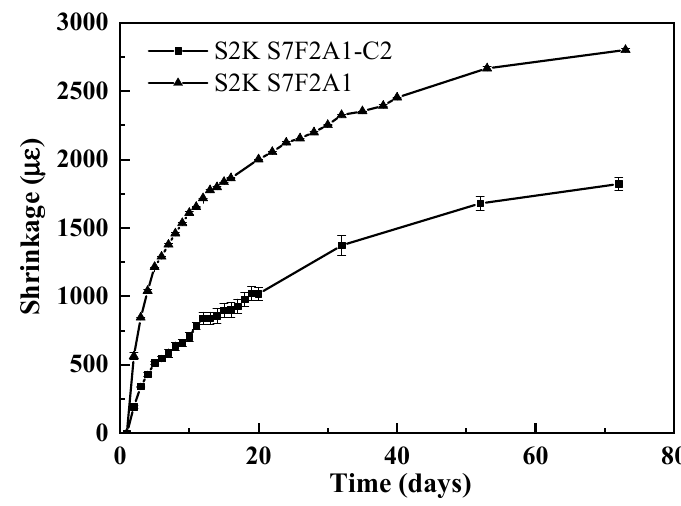
Figure 9 : Mortars’ drying shrinkage vs . curing days.